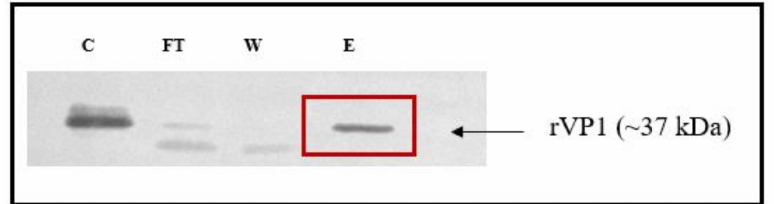
Figure 3. Validation of recombinant VP1 in the immunoblot. Lanes: C: crude lysate, FT: flow-through, W: wash, and E: eluate from Ni-NTA column eluted with 500 mM imidazole. A band at the 37 kDa indicated the purified recombinant VP1